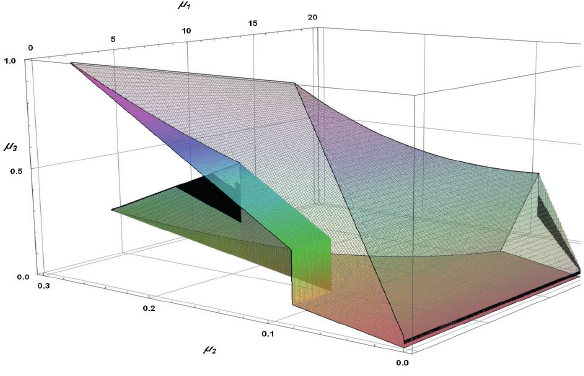
Figure 8 Partial definition area for subset A